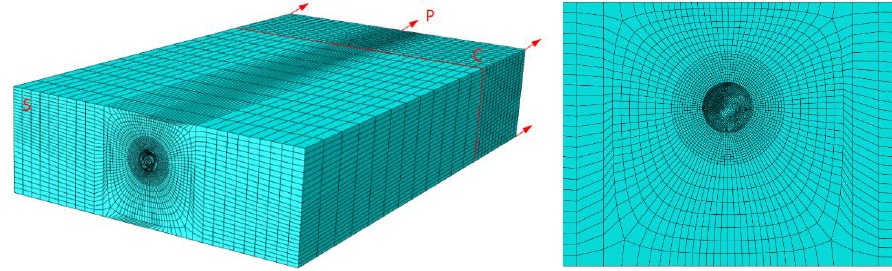
√ Figure 11. Model of specimen from test series √area > 1000 µm including a spherical gas pore. Figure 11. Model of specimen from test series area > 1000 µ m including a spherical gas pore. Figure 11. Model of specimen from test series √area > 1000 µm including a spherical gas pore. Figure 11. Model of specimen from test series √area > 1000 µm including a spherical gas pore.